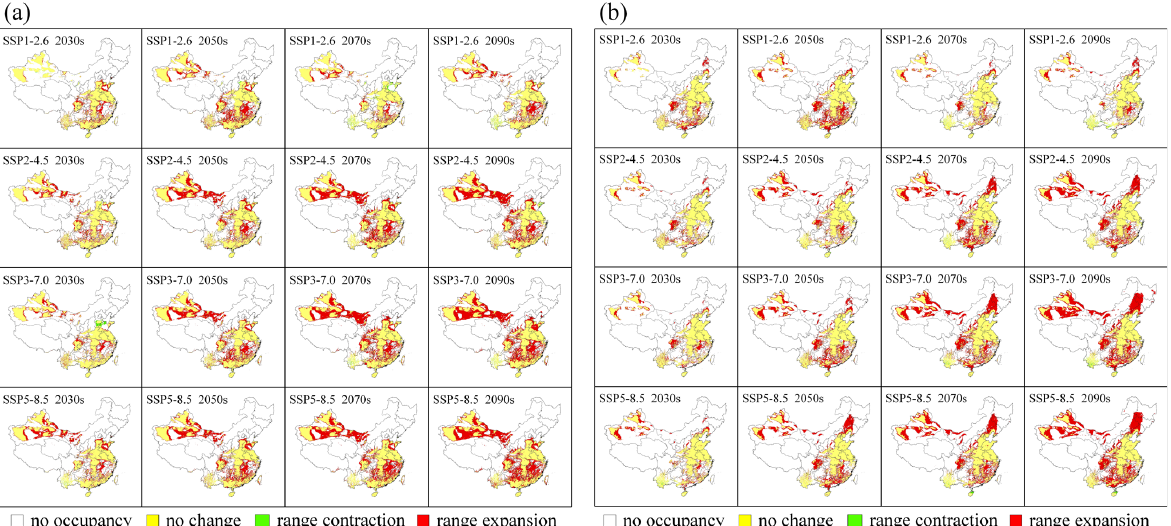
Figure 5. Predicted habitat changes for ( a ) MEAM1 and ( b ) MED cryptic species of the Bemisia tabaci species complex in China under future climate scenarios compared with the current status. SSP, shared socioeconomic pathway.